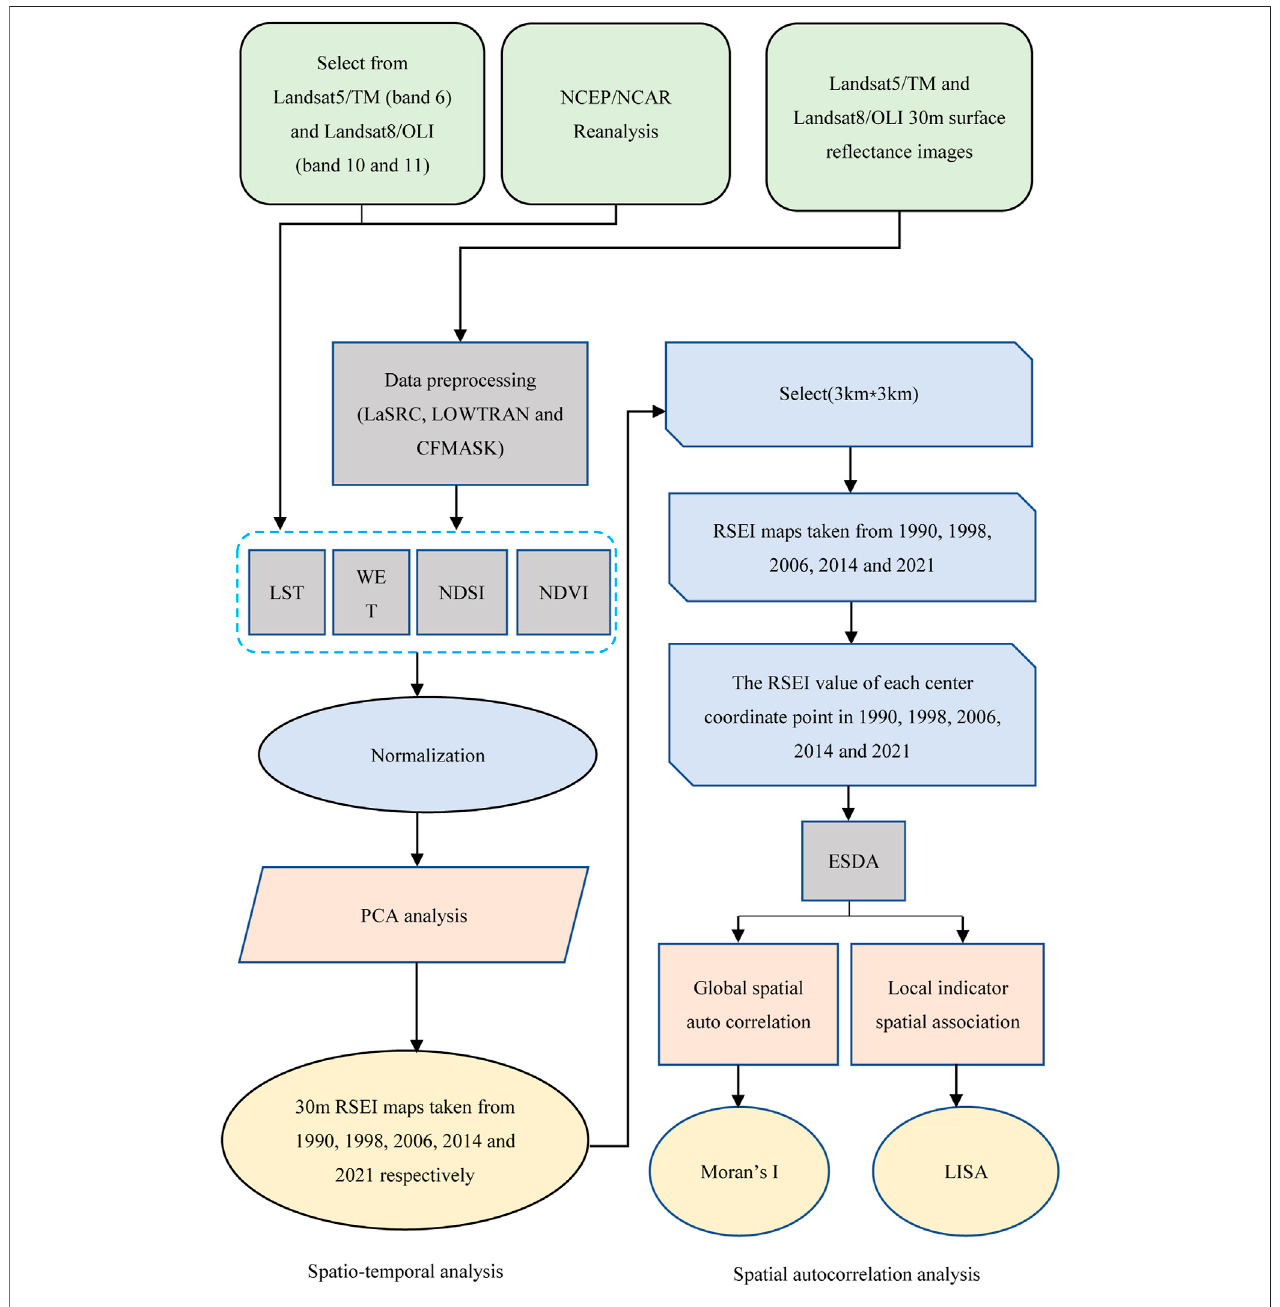
FIGURE 1 | Technology